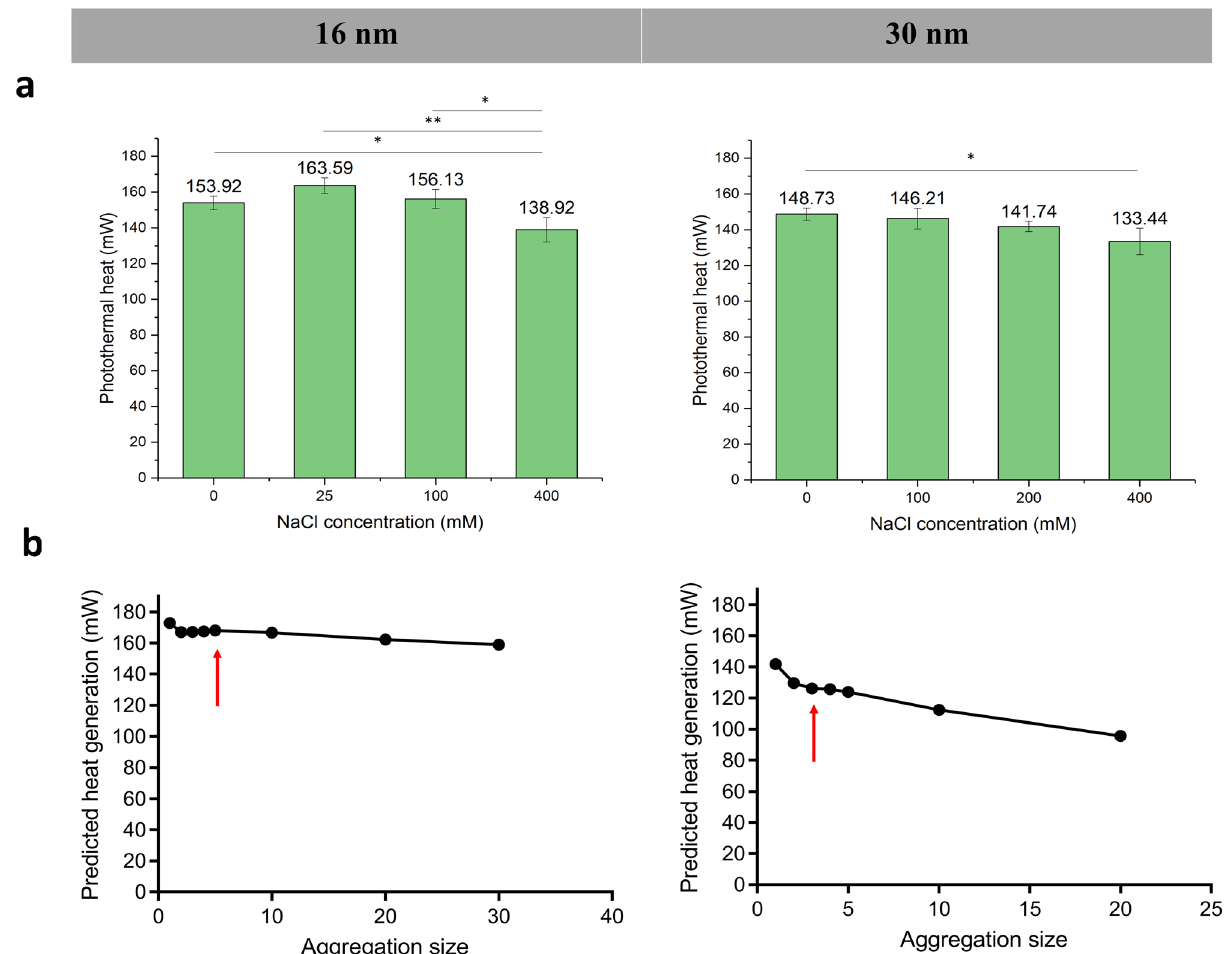
Figure 4. ( a ) Photothermal conversion experiment result of aggregated GNPs under 190 mW 532 nm wavelength CW laser. Large aggerates formed by 16 nm and 30 nm GNP showed significant lower heat comparing to discrete GNPs *p < 0.05, **p < 0.01. ( b ) Heat generation by converting optical properties predicted in modelling. Heating is shown to decline consistently with larger size aggregates. Predicted heat pointed by red arrows correspond to experimental heat generated by GNS aggregate with 400 mM NaCl